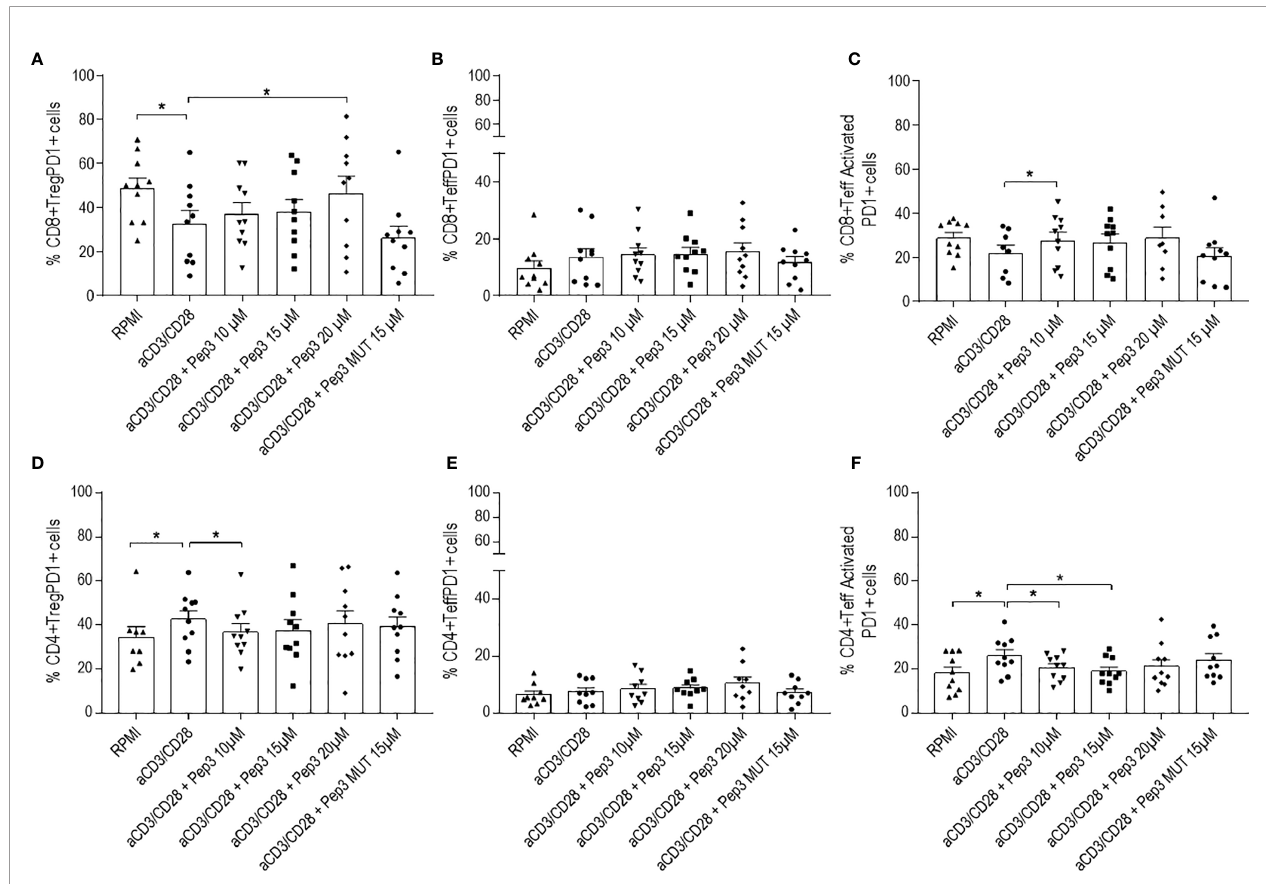
FIGURE 3 | Frequency of CD8+PD1+ and CD4+PD1+ cell populations relative to thyroid cancer patients PBMC upon treatment with peptide 3 and subsequent stimulation with anti-CD3/CD28 beads for 4 days. Upper graphs show the percentages of CD8+ Treg PD1+ cells (A) , CD8+ Teff PD1+ cells (B) , CD8+ Teff activated PD1+ cells (C) . Lower graphs show the percentages of CD4+ Treg PD1+ cells (D) , CD4+ Teff PD1+ cells (E) , CD4+ Teff activated PD1+ cells (F) . Percentage of PD1+ cells was evaluated in comparison to the corresponding parental subset under evaluation. Statistical signi fi cance was evaluated using Wilcoxon matched-pairs signed rank test. Data are expressed as mean ± SEM, and each dot corresponds to an individual TC patient (n = 9-10). *p <